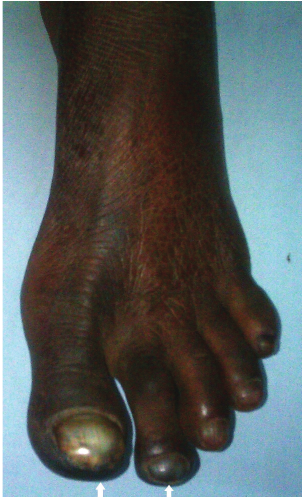
Figure 3: Volume rendering image of CT angiogram. The arrows show the course of persistent sciatic artery through the thigh and its distal run-off to the popliteal artery. Note that the popliteal artery of the opposite limb is supplied by the superficial femoral artery.